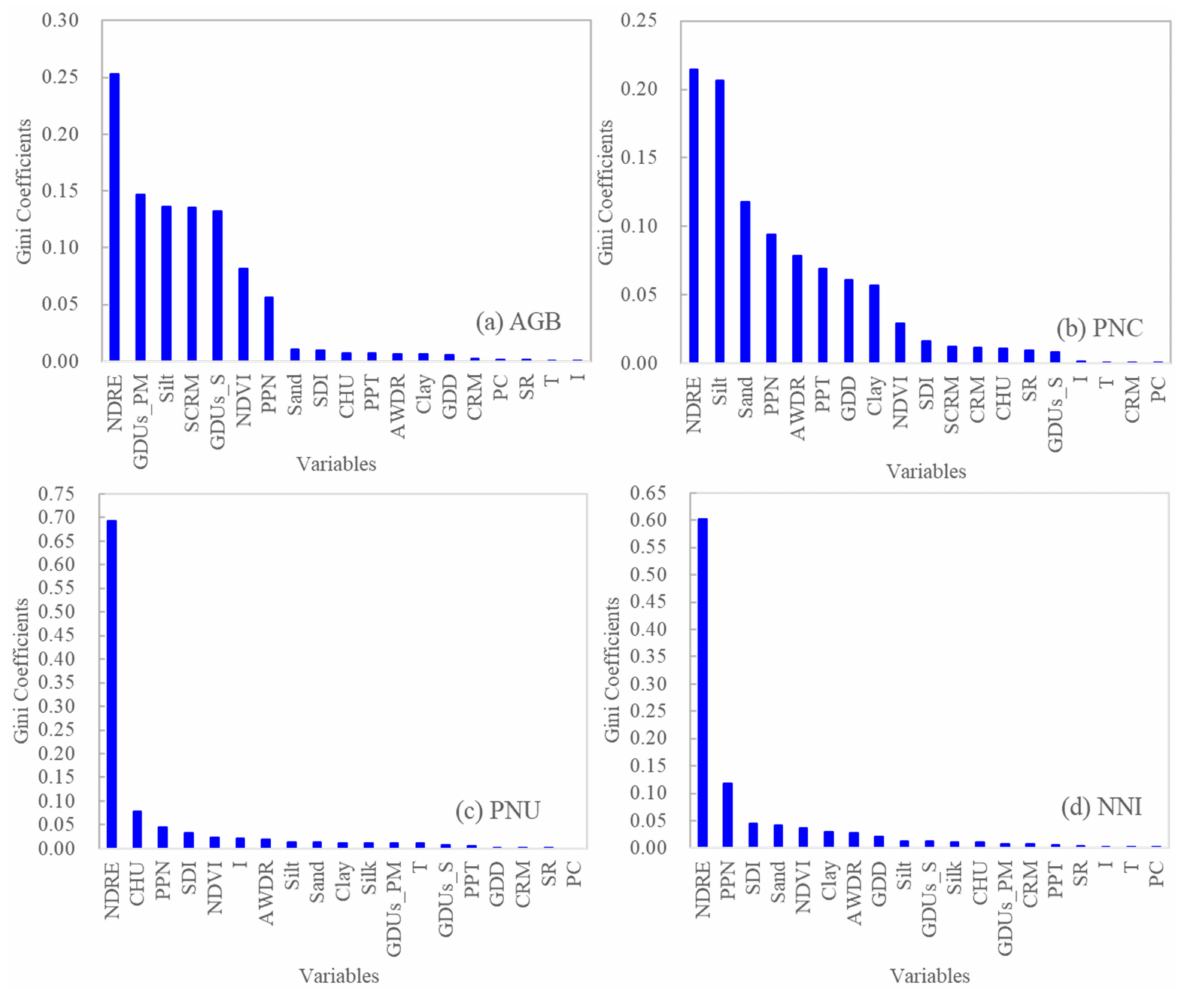
Figure 3. Relative importance represented by Gini coefficients of different input variables used in the random forest regression models using sensor-provided vegetation indices (NDVI and NDRE) and genetic, environmental, and management variables for predicting aboveground biomass (AGB) ( a ), plant N concentration (PNC) ( b ), plant N uptake (PNU) ( c ), and N nutrition index (NNI) ( d ). Note: NDRE: normalized difference red edge. NDVI: normalized difference vegetation index. CRM: comparative relative maturity. SCRM: silk comparative relative maturity. GDUs_S: growing degree units to silk. GDUs_PM: growing degree units to physiological maturity. PPT: total precipitation from planting to sensing. SDI: Shannon diversity index. AWDR: abundant and well-distributed rainfall. CHU: corn heat units. GDD: growing degree days. PPN: preplant N rate. I: irrigation. T: tillage. SR: seeding rate. PC: previous